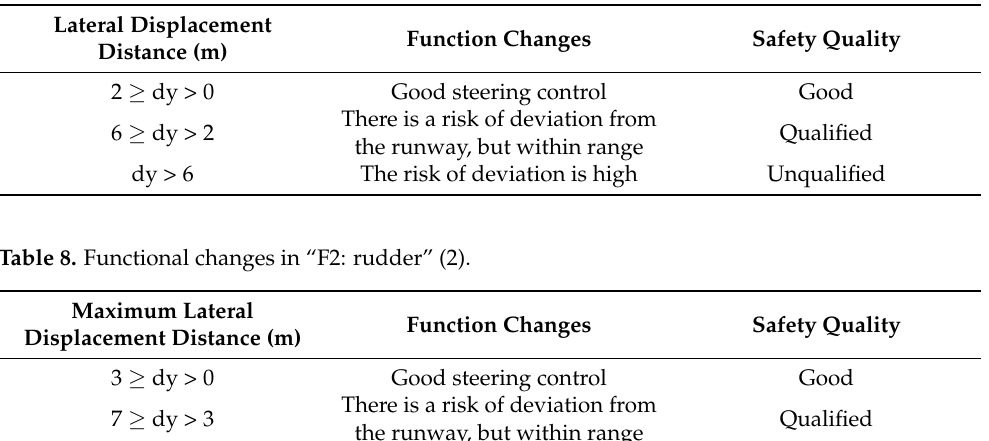
Table 7. Function changes in “F2: rudder” (1).